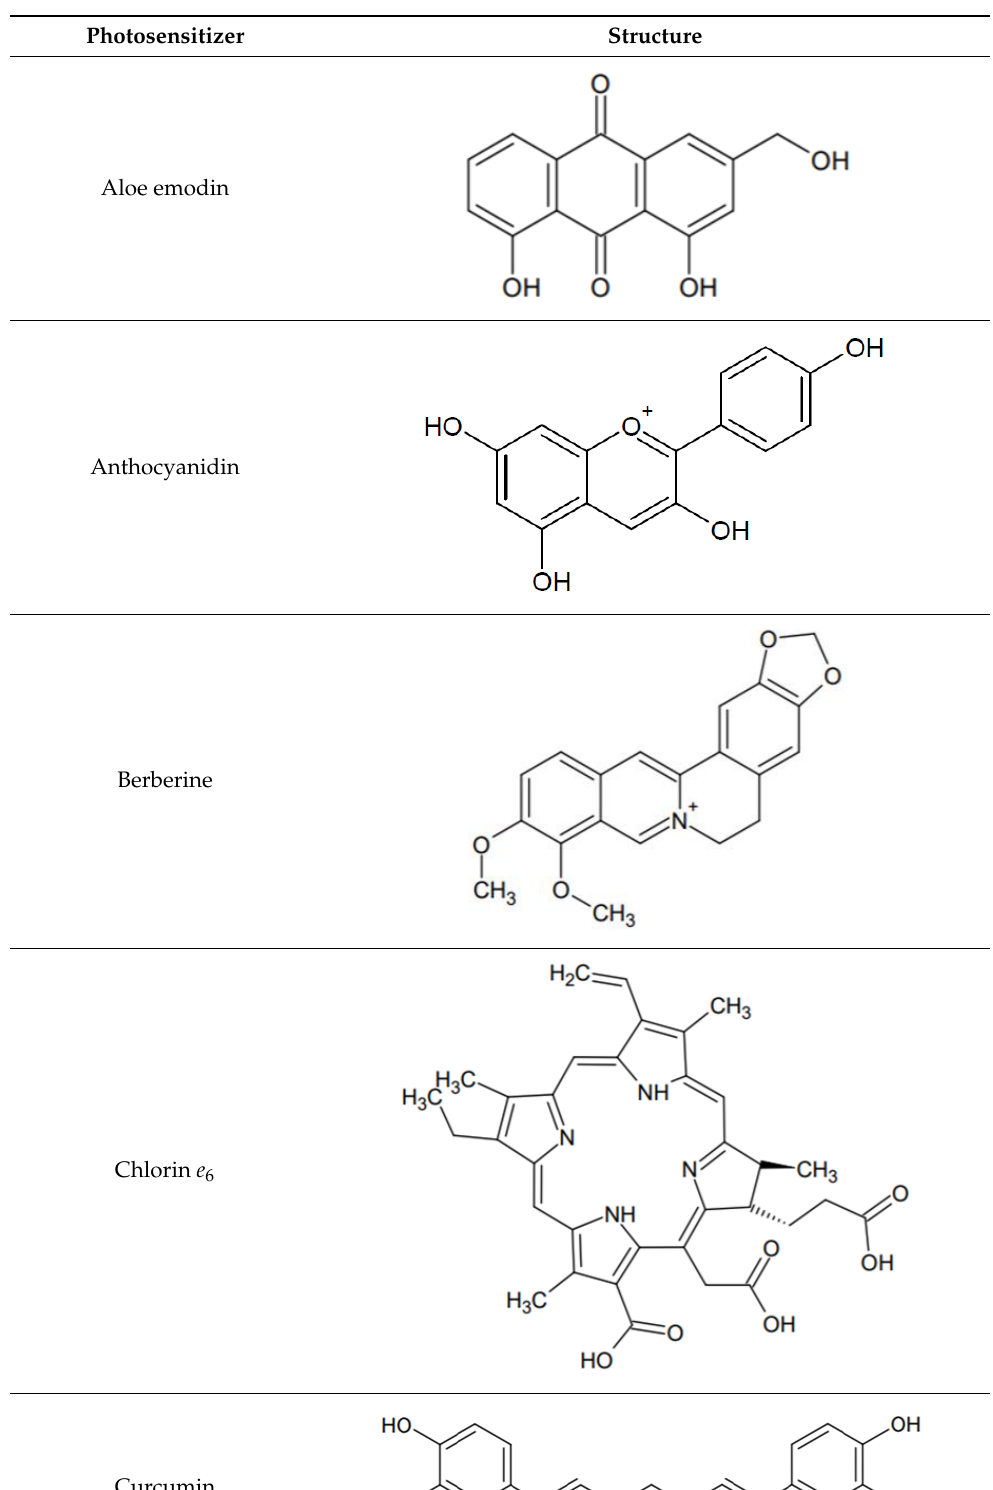
Table 2. Structures of selected photosensitizers from edible